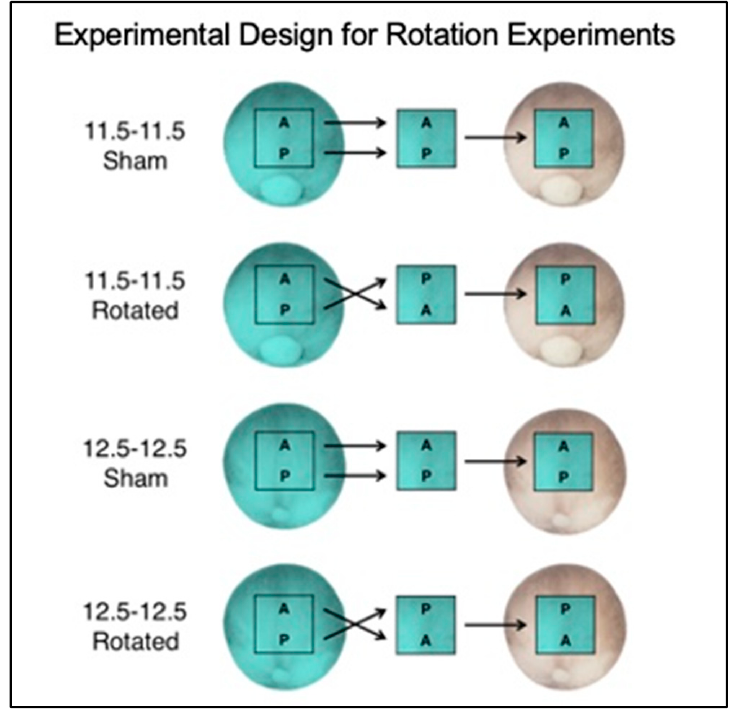
Figure 1. Schematic of experimental design for experiments. Fluorescein-injected donor embryo is on the left and uninjected host embryo is on the right. Dorsal view, with anterior up and posterior down. The precise tissue removed was determined from preliminary fate mapping experiments and published work [54].